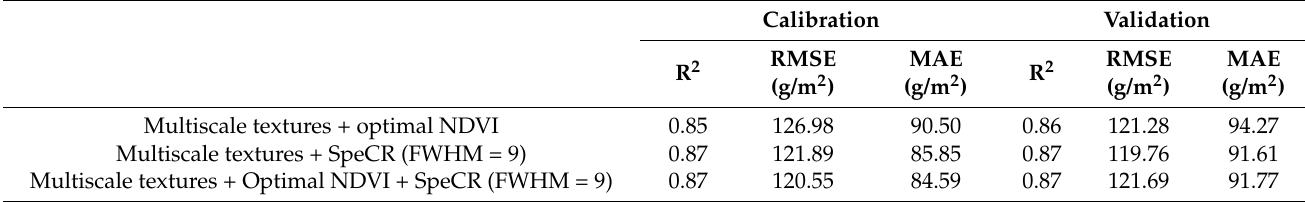
Table 3. Performance of the LSSVM regression models based on the combination of multiscale textures and biomass-sensitive spectral features for winter wheat biomass estimation.